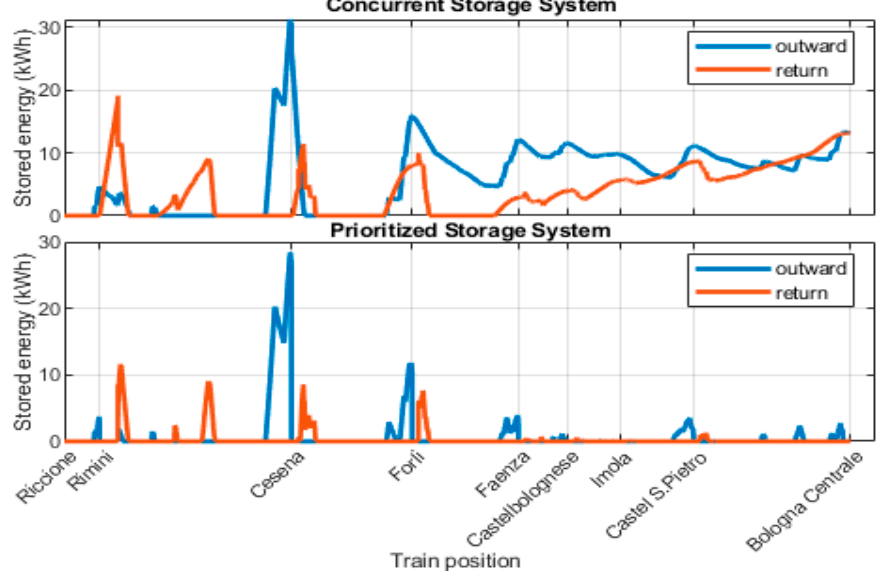
Figure 12. Energy stored in the ESS in the substation of Cesena during the round trip.